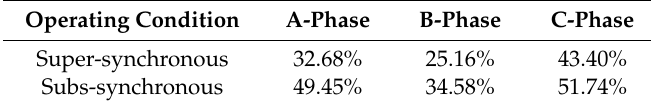
Table 4. Second harmonic contents of three-phase short-circuit current under two